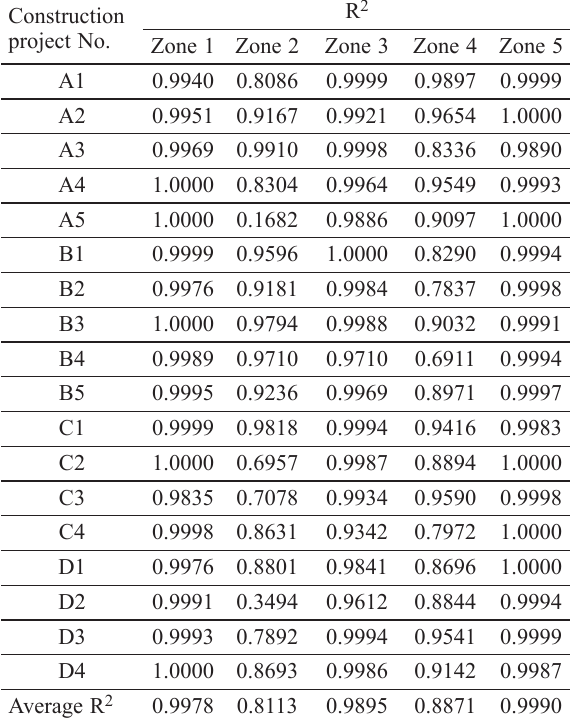
Table 7. Constants of the regression equations for zone 2 of all 18 projects Construction project No.